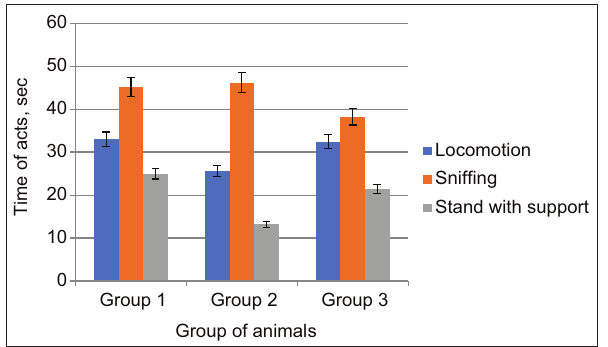
Figure-4: Changes in the number of acts of research and emotional activity of animals when exposed from the Samsung Galaxy J1 Mini and Xiaomi Redmi S2 phones.